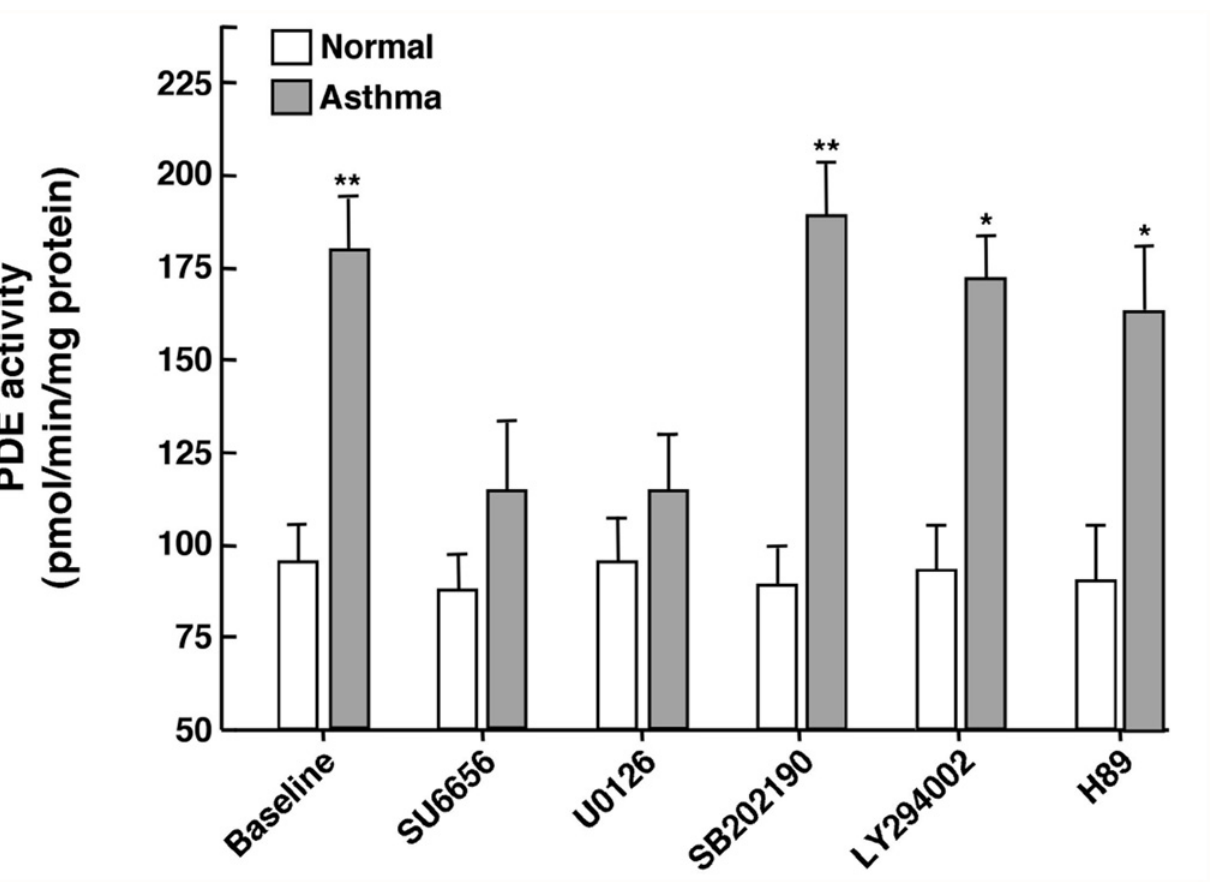
Fig 4. Comparison of effects of small molecule inhibitors of specific G βγ -regulated downstream signaling proteins on PDE activity in asthmatic vs. normal HASM cells. Relative to baseline in normal HASM cells, constitutively heightened baseline PDE activity in asthmatic HASM cells is suppressed to near normal levels at 2 hr following treatment with either the c-Src inhibitor, SU6656, or the MEK-ERK1/2 inhibitor, U0126, whereas treatment with inhibitors of either p38 MAPK (SB202190), PI3K (LY294002), or PKA (H89) had no significant effect. Note: neither inhibitor had an appreciable effect on PDE activity in normal HASM cells. Data are mean ± SE values, each based on 3 – 6 determinations. Comparisons between asthmatic vs. normal HASM cells are made using two-tailed Student t-test. * p < 0.05; ** p <